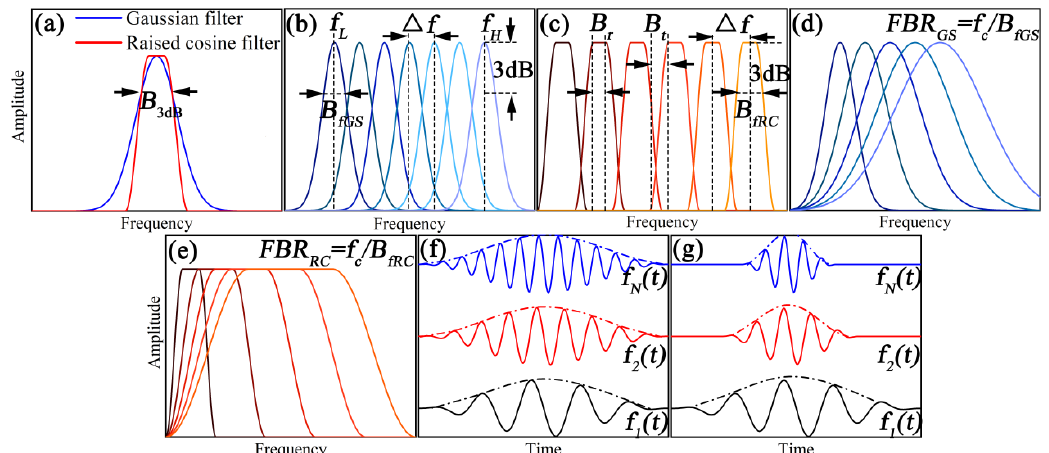
Figure 2. ( a ) Comparison of GS and RC filters with the same bandwidth, frequency impulses of ( b ) GS, ( c ) RC, ( d ) FBR-GS and ( e ) FBR-RC filters, time impulses of ( f ) RC and ( g ) FBR-RC filters.